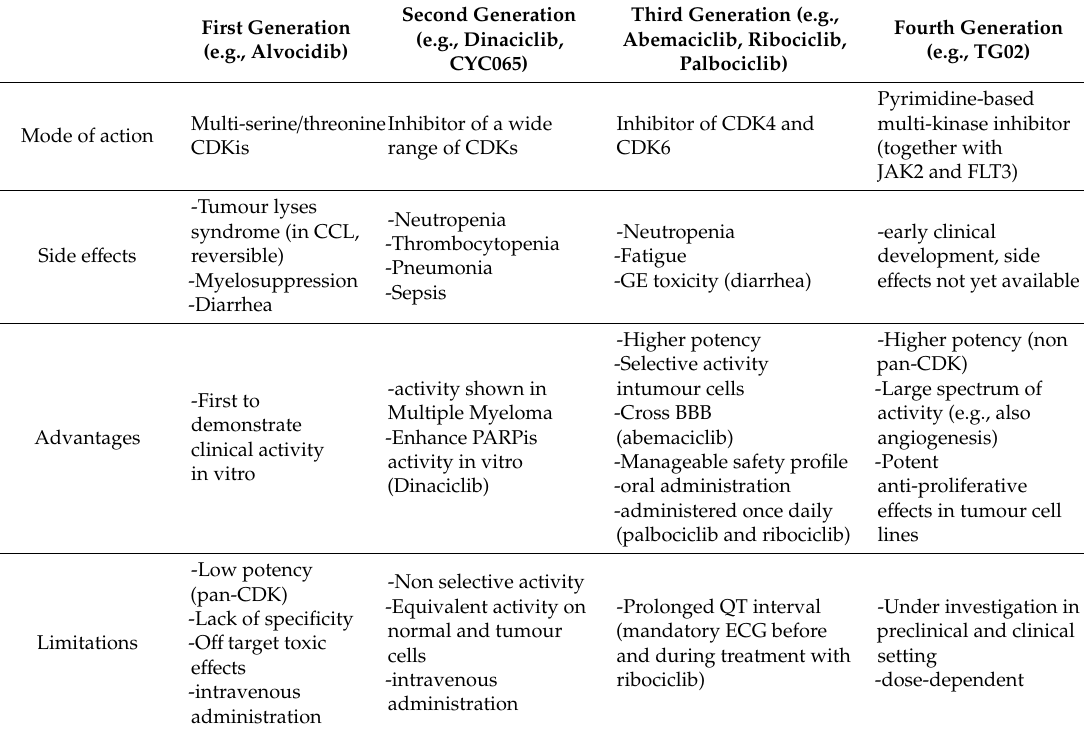
Table 1. CDKis generations and